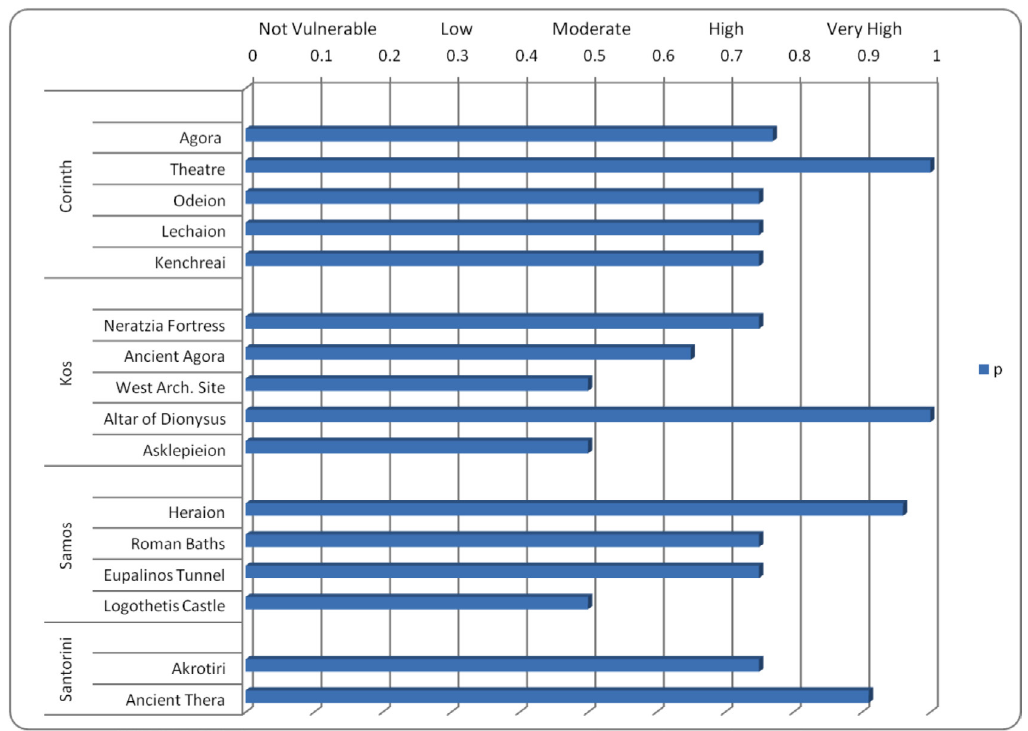
Figure 8. The physical vulnerability indicator for the archaeological sites under